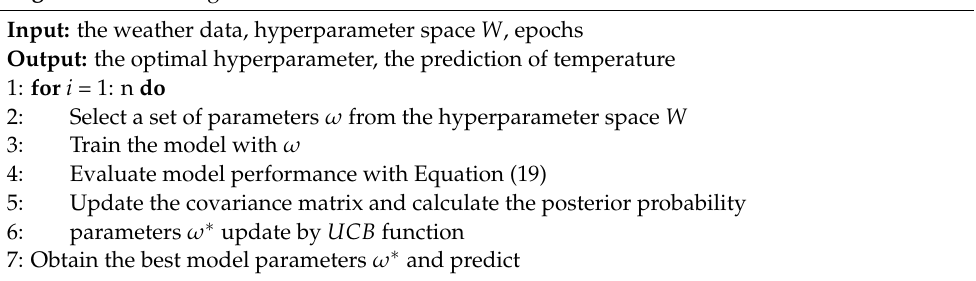
Algorithm 1 Training of the BMAE-Net